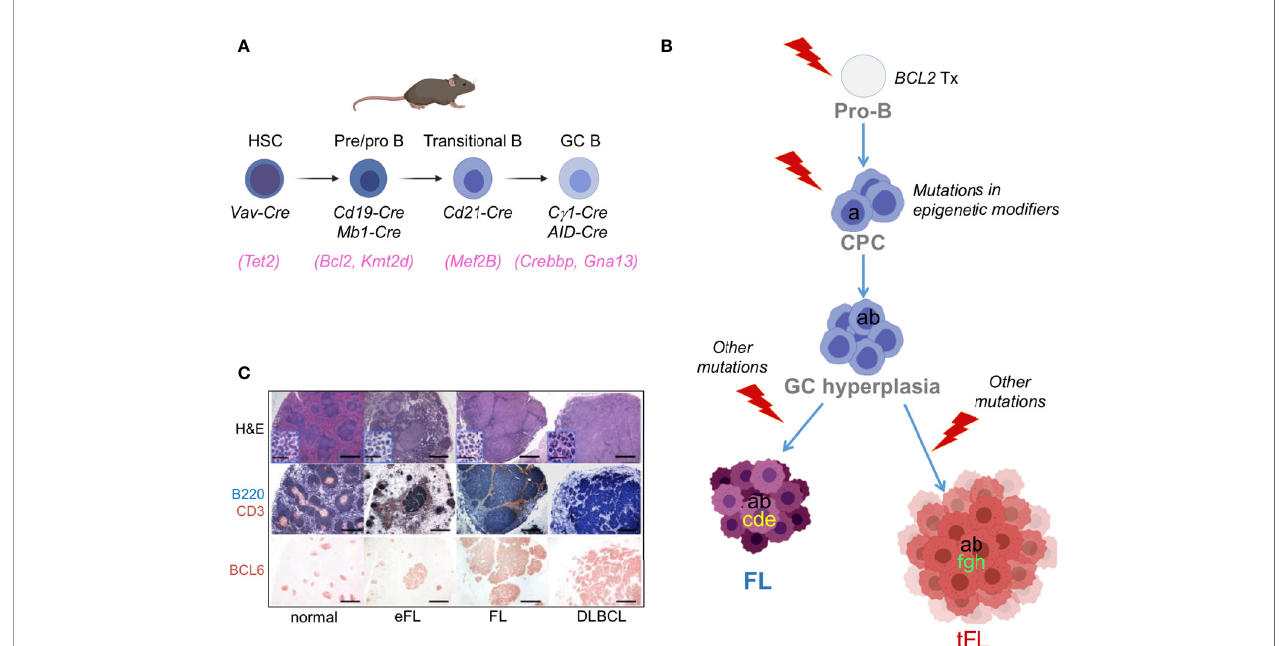
FIGURE 3 | Benchmarking GC-derived GEMMs. (A) Cre-drivers utilized to achieve deletion/mutation of lymphoma-associated genes at the appropriate stage of B cell development, namely a HSC (e.g. TET2 mutations), an early B cell (e.g. BCL2 translocations), a transitional/mature B cell (utilized for genes whose endogenous promoter is speci fi cally induced in the GC, e.g. MEF2B ), or a GC-B cell (e.g. CREBBP/KMT2D ). (B) Divergent evolution model for the pathogenesis of FL and tFL inspiring the construction of compound GEMMs. The original B cell clone is on top; based on genetic evidence, BCL2 translocations are thought to represent the earliest event, which takes place in a pro-B cell as a by-product of the VDJ recombination process. Subsequent gain of CREBBP and KMT2D mutations by a postulated common mutated precursor cell primes epigenetic reprogramming, favouring its persistence for years before the independent acquisition of distinct genetic alterations leads to fi nal clonal expansion and malignant transformation into a FL or a tFL, through branching evolution. (C) Representative histo-pathological and immuno-phenotypic characterization of lymphoproliferative diseases developing in GEMMS of lymphoma [from